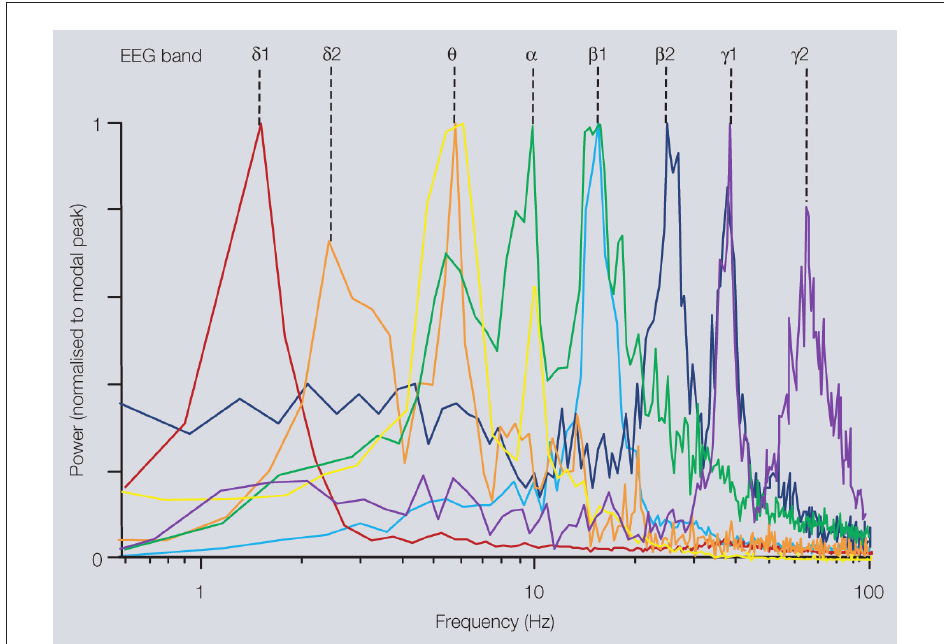
Figure 1 | Multiple modal peak frequencies of persistent rhythms generated in isolated neocortex in vitro . All rhythms were generated in secondary somatosensory (parietal) cortical slices maintained in artificial cerebrospinal fluid (aCSF). Rhythms were recorded as local field potentials (LFPs), resulting spectra (from 60 s epochs of data) are plotted with powers normalised to modal peak. Delta1 ( δ 1, c.1.5 Hz) rhythms were generated in control slices spontaneously after > 1 h incubation in normal aCSF. Delta2 ( δ 2, 2–3 Hz) rhythms were generated by bath application of cholinergic agonist carbachol (2 μ M). Both delta rhythms had maximal amplitudes in LV. Theta ( θ , 6–8 Hz) rhythms were recorded in layers II/III in the presence of the glutamatergic receptor agonist kainate (10 nM) and occurred concurrently with δ 2 rhythms in LV. Alpha ( α , c.10 Hz) rhythms were generated following transient activation of cortex by pressure ejection of glutamate. Peak amplitude was in LV and was present concurrently with θ and β 1 rhythms in LII/III and LIV, respectively. Beta1 ( β 1, 13–17 Hz) rhythms were generated alone by partial blockade of AMPA/kainate receptors following tonic activation by kainate (400 nM). Beta2 ( β 2, 22–27 Hz) rhythms were generated in LV by kainate (400 nM) and always occurred concurrently with gamma1 ( γ 1, 30–50 Hz) rhythms in LII/III in this brain region. Gamma2 ( γ 2, 50–80 Hz) rhythms were also generated by kainate (400 nM) but occurred in LV in aCSF with reduced chloride ion concentration. Additional peak frequencies at ≥ 100 Hz are generated by brief, intense periods of excitation but rarely meet criteria for persistence and so are not considered